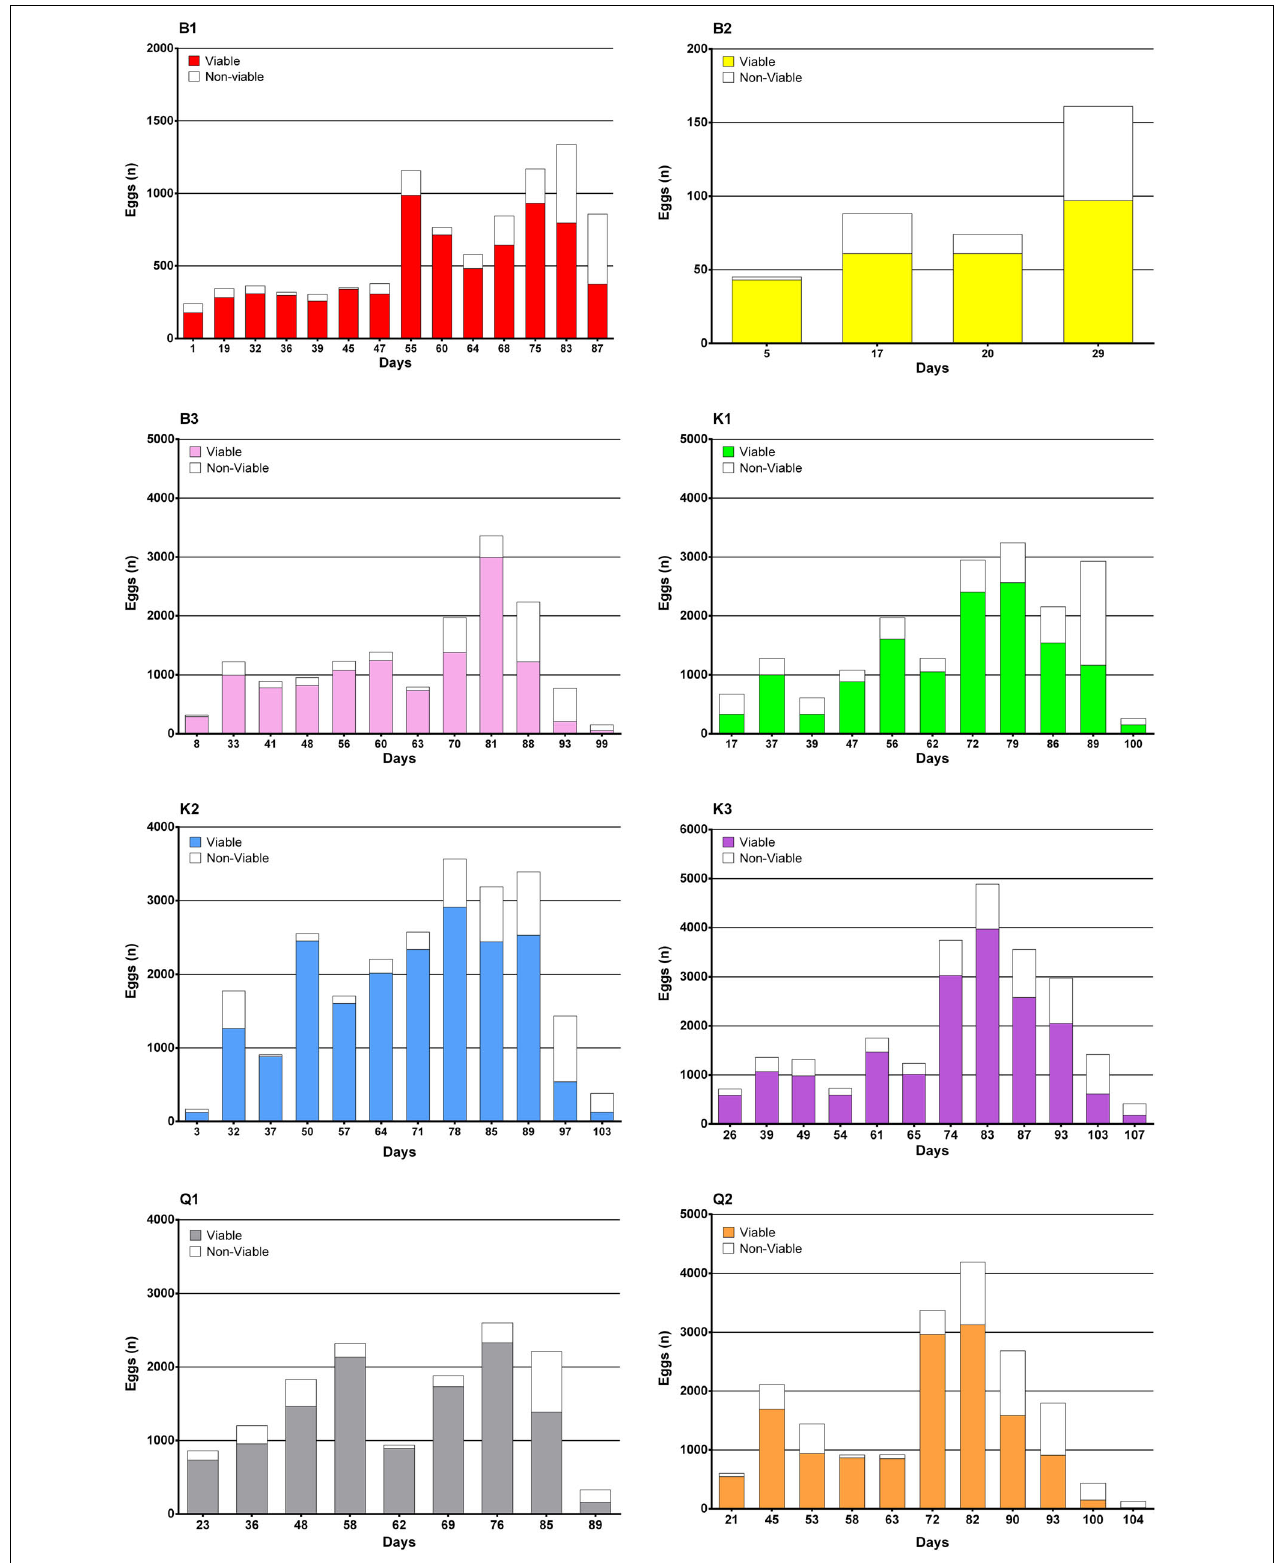
FIGURE 9 | Viable and non-viable egg numbers per batch day and